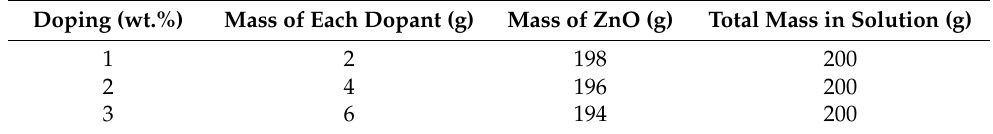
Table 1. Weight% of doping agents (LA, LN, and BN) mixed in ZnO solution. Doping (wt.%) Mass of Each Dopant (g)